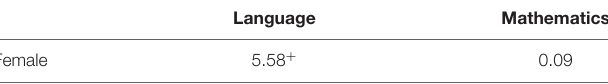
TABLE 4 | Results for likelihood ratio tests for random coefficients of